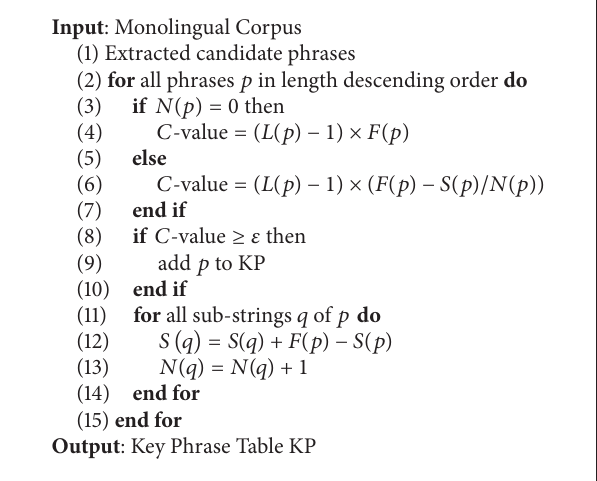
Algorithm 2: Key phrase extraction from monolingual corpus.